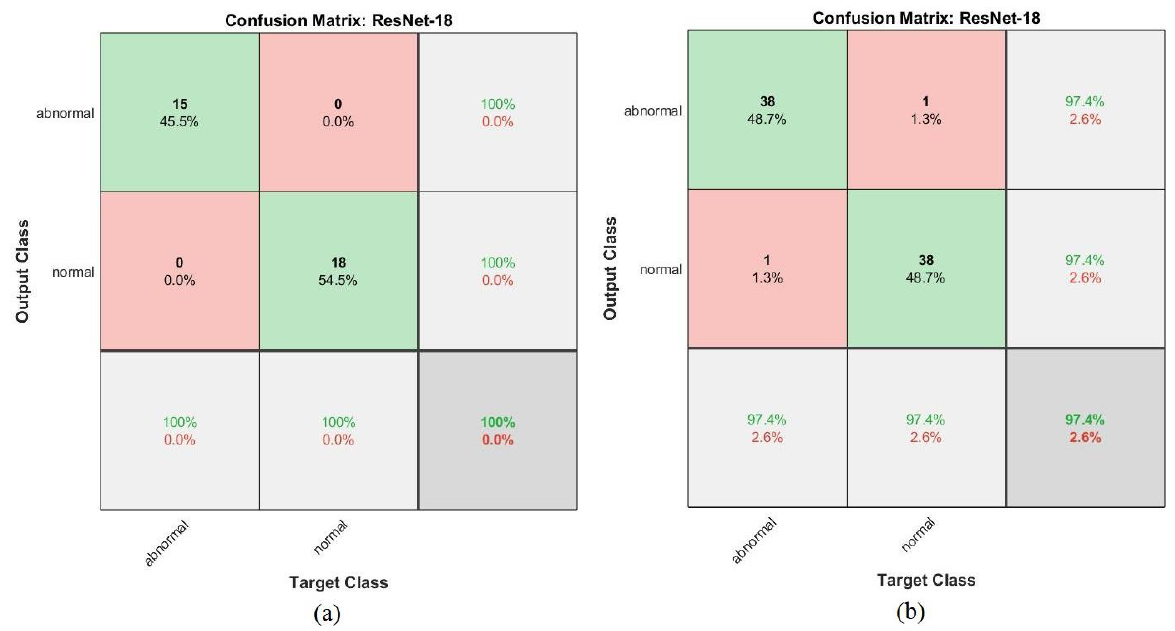
Figure 24. Confusion matrix for the ResNet-18 model for the ( a ) ALL_IDB1 and ( b ) ALL_IDB2 datasets.